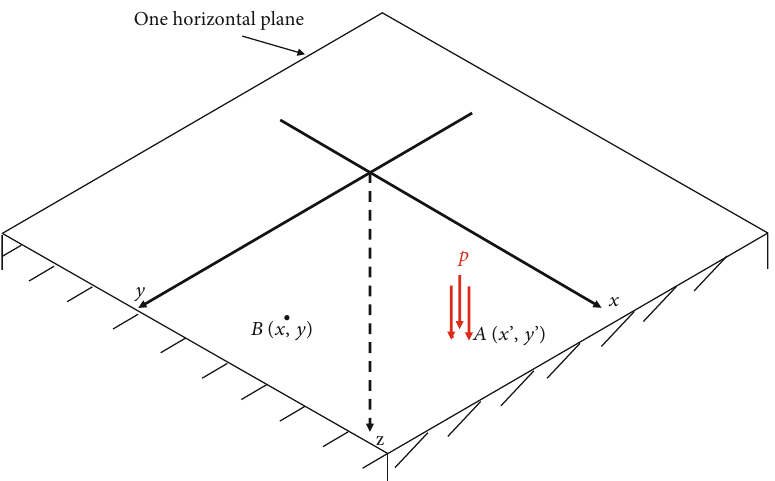
ð x , y Þ represents e